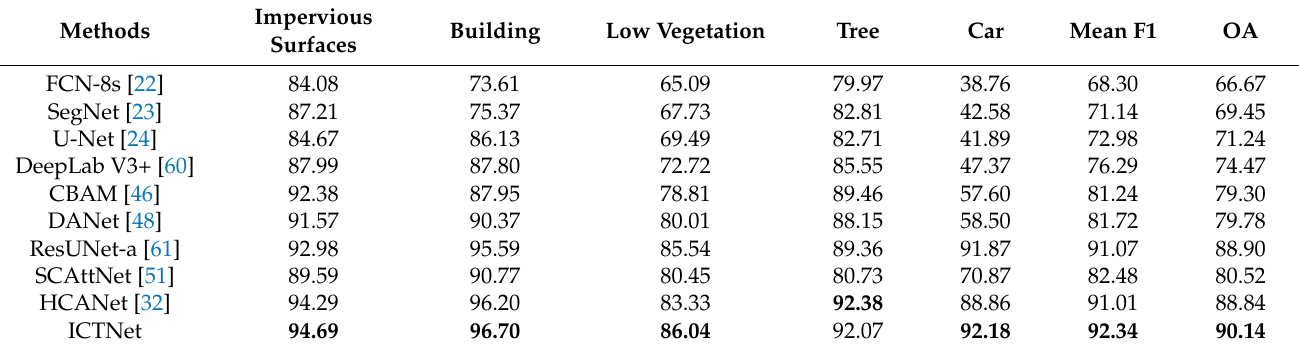
Table 2. Results of the ISPRS Vaihingen test set. The class-wise F1-score, mean F1-score, and OA are